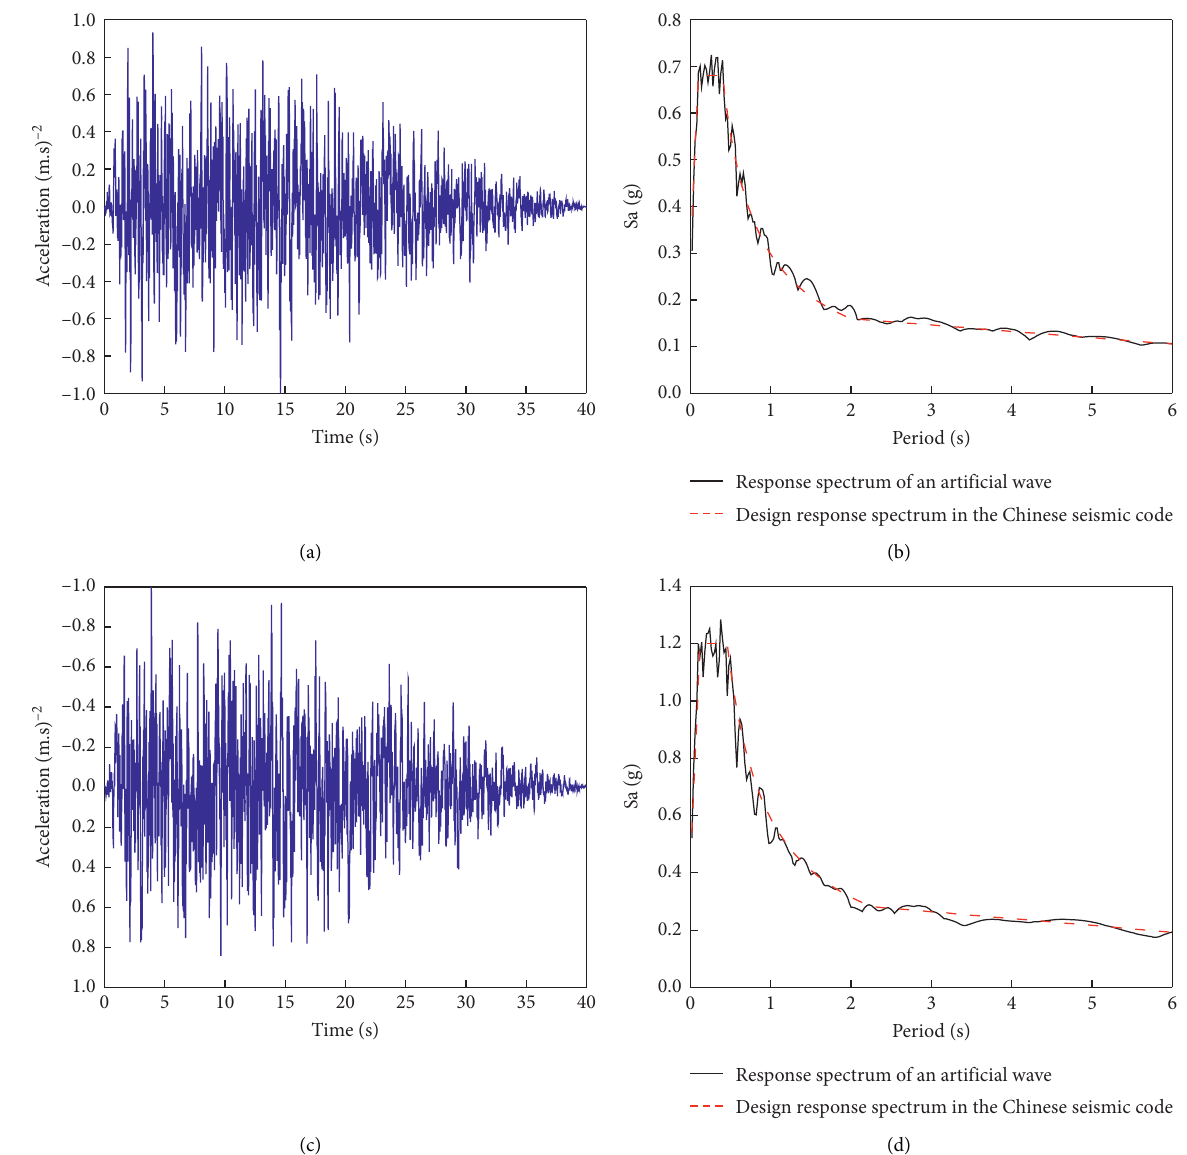
Figure 4: Acceleration-time history and response spectrum of an artificial wave. (a) Acceleration-time history under moderate earthquake. (b) Response spectrum under moderate earthquake. (c) Acceleration-time history under strong earthquake. (d) Response spectrum under strong